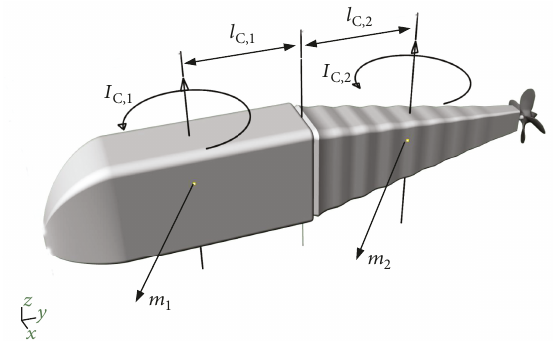
Figure 1: Mechanical structure of the proposed semibiomimetic robotic fi